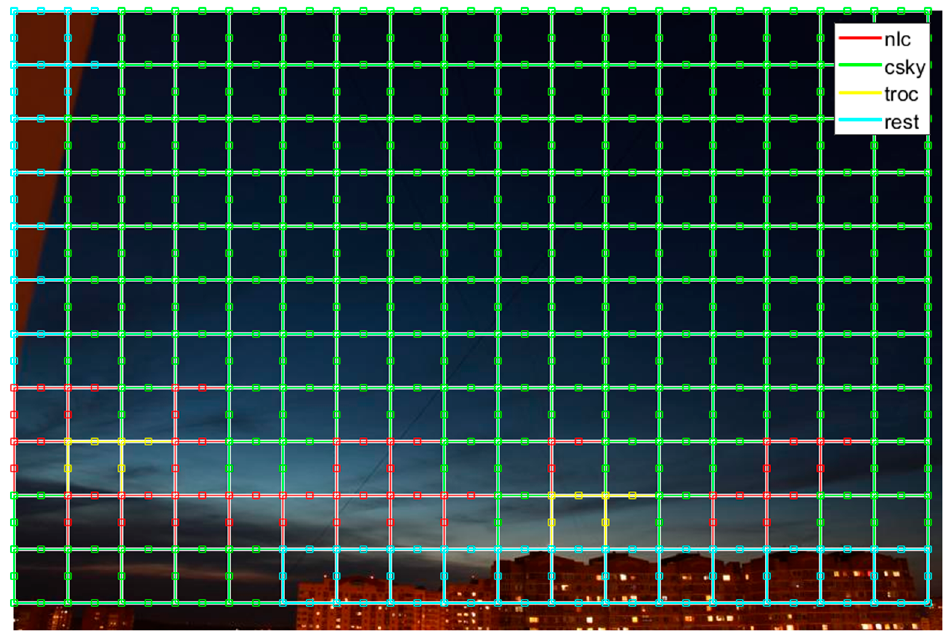
Figure 15. An example of false-positive detections by the CNN algorithm.